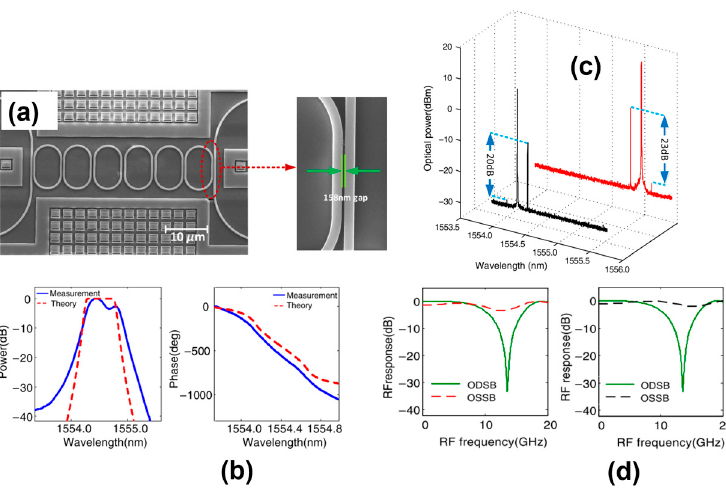
Figure 2. ( a ) Top-view scanning electron microscope image of the fabricated silicon-on-insulator microring coupled-resonator optical waveguides (CROW) filter reported in [81]. ( b ) Measured and theoretical ((amplitude (left) and phase (right)) response of sixth-order CROW filter. ( c ) Optical spectrum of the generated optical single-sideband (OSSB) signal with lower sideband suppression (black line) and upper sideband suppression (red line) when modulated at 20 GHz (after passing through the optical filter). ( d ) RF responses of the optical dual sideband (ODSB) and OSSB system with (left) upper sideband suppression (red dashed line) (right) lower sideband suppression (black dashed line). Courtesy of Xiaoke Yi [81].